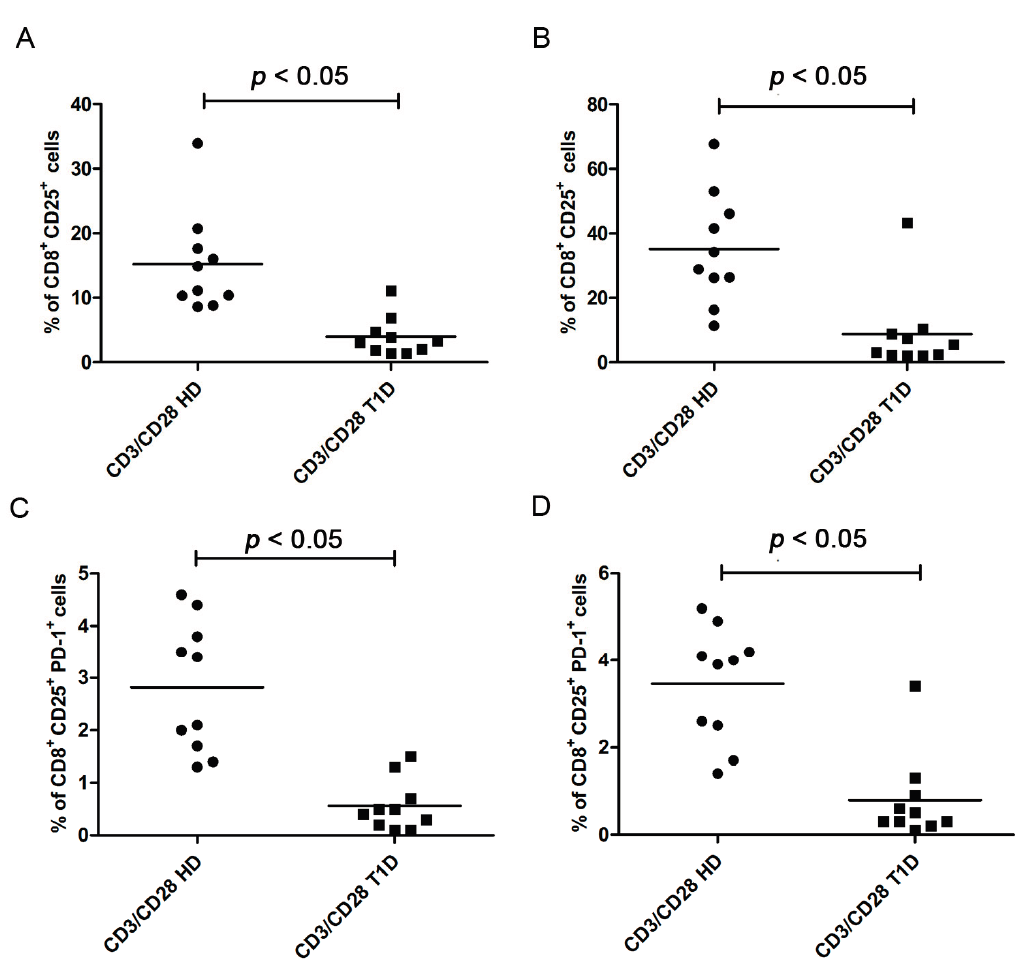
Figure 4. Analysis of CD8 + CD25 + subsets after CD3/CD28 stimulation in healthy controls and in T1D patients. Upper panel graphs show the percentages of CD8 + CD25 + cells after four days ( A ) and six days ( B ) of stimulation in healthy controls and in T1D patients; Bottom panel graphs show the percentages of CD8 + CD25 + PD-1 + cells after four days ( C ) and six days ( D